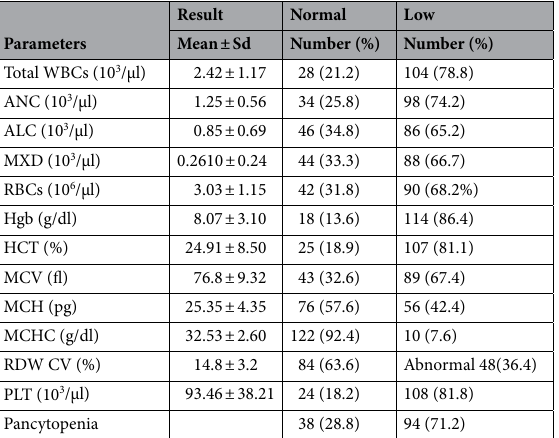
Table 3. Hematological profiles of VL patients at Tefera Hailu Memorial Hospital, Sekota, Northeast Ethiopia from January 2017 to December 2021.